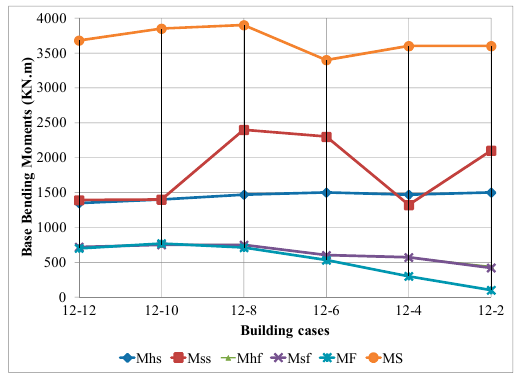
Figure 8. Base bending moment in buildings with different configurations.